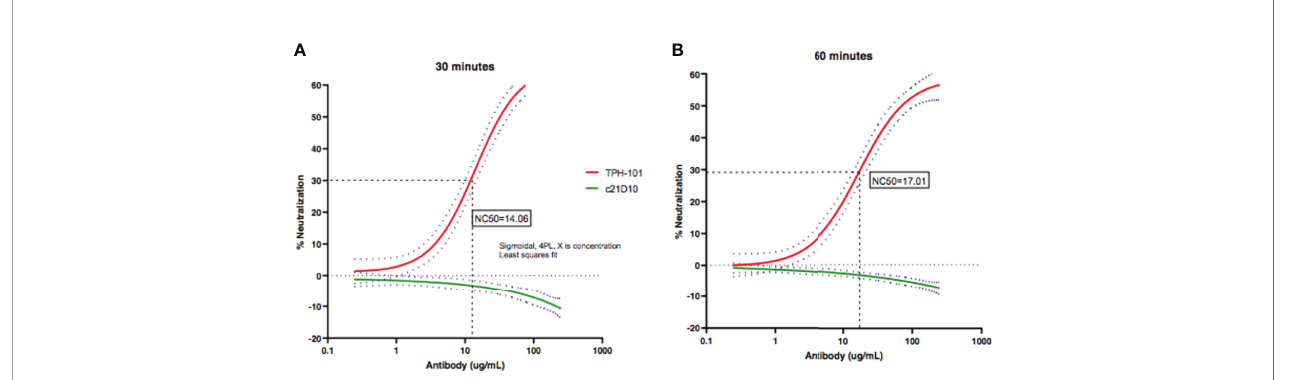
FIGURE 2 | Quanti fi cation of the neutralizing activity of humanized anti-Gmd mAb (TPH-101) in vitro . The indicated concentration ( m g/ml) of puri fi ed anti-Gmd TPH- 101 mAb or irrelevant control mAb (c21D10) was added to 10 m g/ml of recombinant Gmd prior to incubation with 0.075% heat-killed M. luteus cell wall extract in the presence of 0.5% Triton X-100 at 37°C for 30 min (A) or 60 min (B) , and the percentage of lysis was determined as described in Figure 1 . These data were reanalyzed using Sigmoidal, 4PL, X is concentration least squares fi t to quantify the 50% neutralizing concentration (NC 50 ) of TPH-101, which is 14.1 m g/ml in the 30-min incubation (A) and 17.0 m g/ml in the 60-min incubation (B) , respectively. Dotted red and green lines are ±